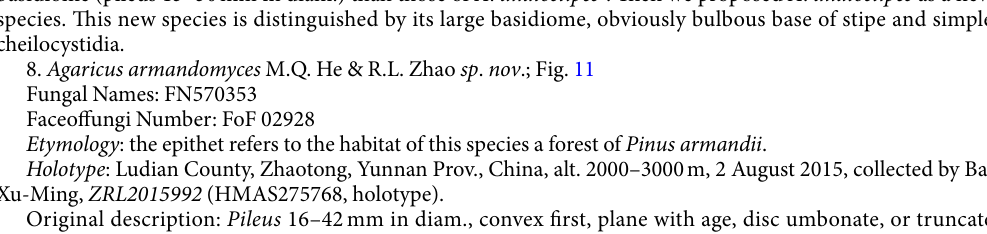
8. Agaricus armandomyces M.Q. He & R.L. Zhao sp . nov .; Fig. 11 Fungal Names: FN570353 Holotype : Ludian County, Zhaotong, Yunnan Prov., China, alt. 2000–3000 m, 2 August 2015, collected by Bai Xu-Ming, ZRL2015992 (HMAS275768, holotype). Original description: Pileus 16–42 mm in diam., convex first, plane with age, disc umbonate, or truncate umbonate, margin decurved when young, then straight with age, slightly exceeding; surface dry, covered by fibrils at the whole cap, forming fibrillose scales, light brown, ochre, or reddish brown, dense at disc and scattered towards the margin; background white or light yellow. Context 4 mm thick, flesh, white at pileus and yellowish brown at stipe. Lamellae 5–6 mm broad, free, crowded, broad, first white, pink or pinkish brown, then brown, edge even, intercalated with lamellulae. Annulus up to 3 mm in diam., fragile, membranous, single, white, pen- dant, smooth at both sides. Stipe 38–40 × 3–5 mm (6–7 mm at base), cylindrical, sometimes with a swallow base, hollow, surface dry, white, fibrillose below the annulus. Odour of almonds. Basidiome flavescent, orange when touching and bruising. Context turning flavescent first, then brown on exposure after few minutes. KOH reaction: positive yellow. Schäffer’s reaction: positive, reddish orange on dry specimen. Basidiospores 4.7–5.3 × 3.2–3.7 μ m, [x = 4.9 ± 0.2 × 3.4 ± 0.1, Q = 1.4–1.6, Q m = 1.4 ± 0.0, n = 20], ellipsoid, 16.2–40 × 8.2–16.7 μ m, smooth, pyriform mostly, broadly clavate and capitate with long narrow stipe, occasion-